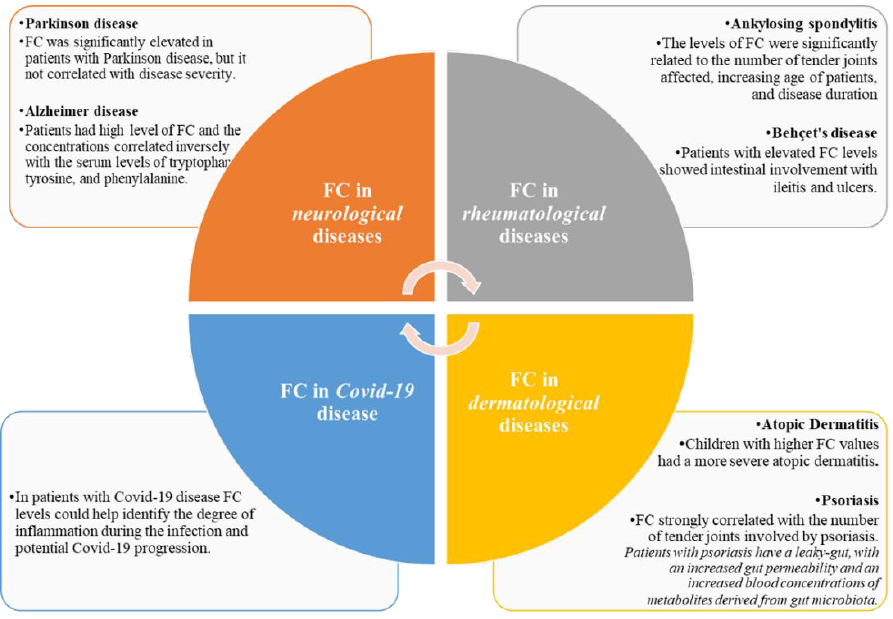
Figure 1. Fecal calprotectin in extra gastro-intestinal diseases.